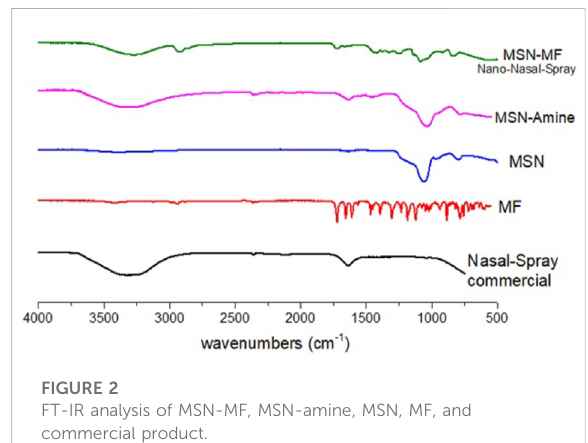
FIGURE 2 FT-IR analysis of MSN-MF, MSN-amine, MSN, MF, and commercial